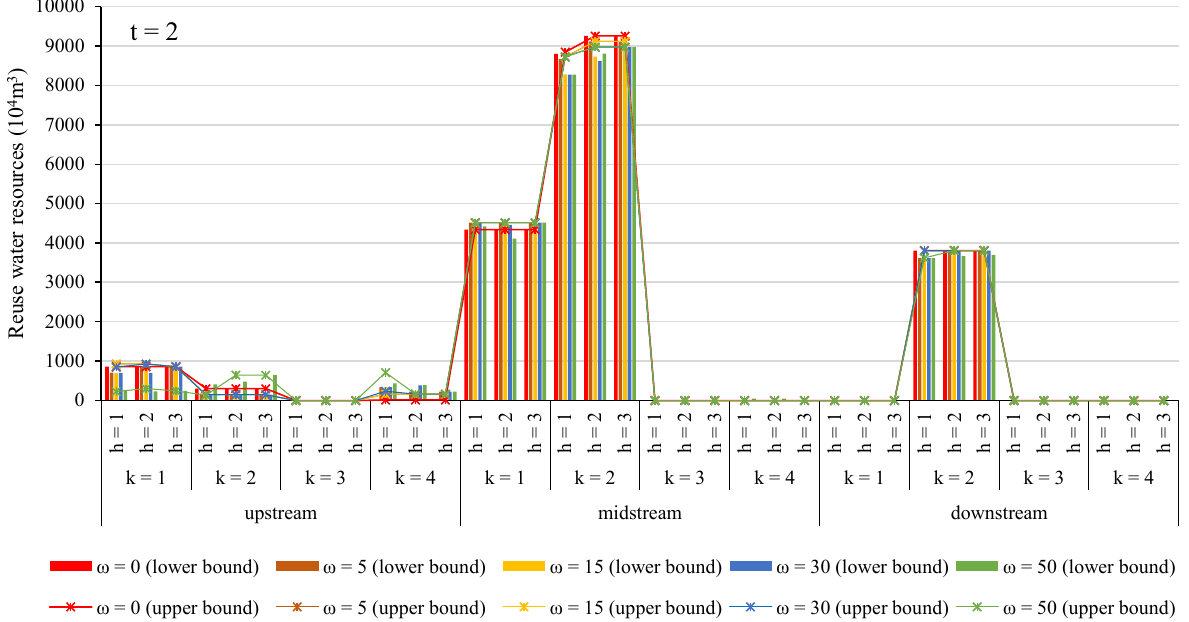
Figure 12. Reused water resources by region in the Fenhe River Basin in period 2.